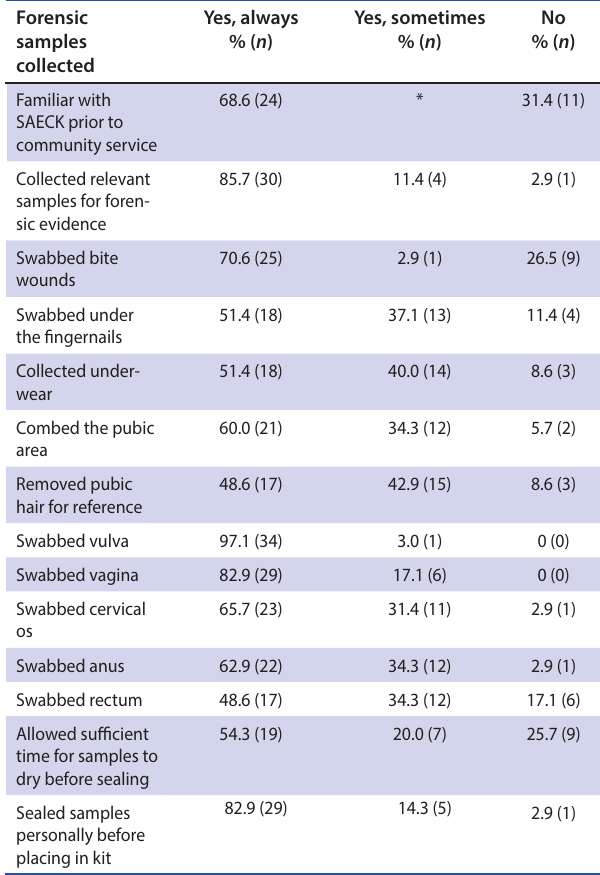
*Indicates that the option was not available for that particular